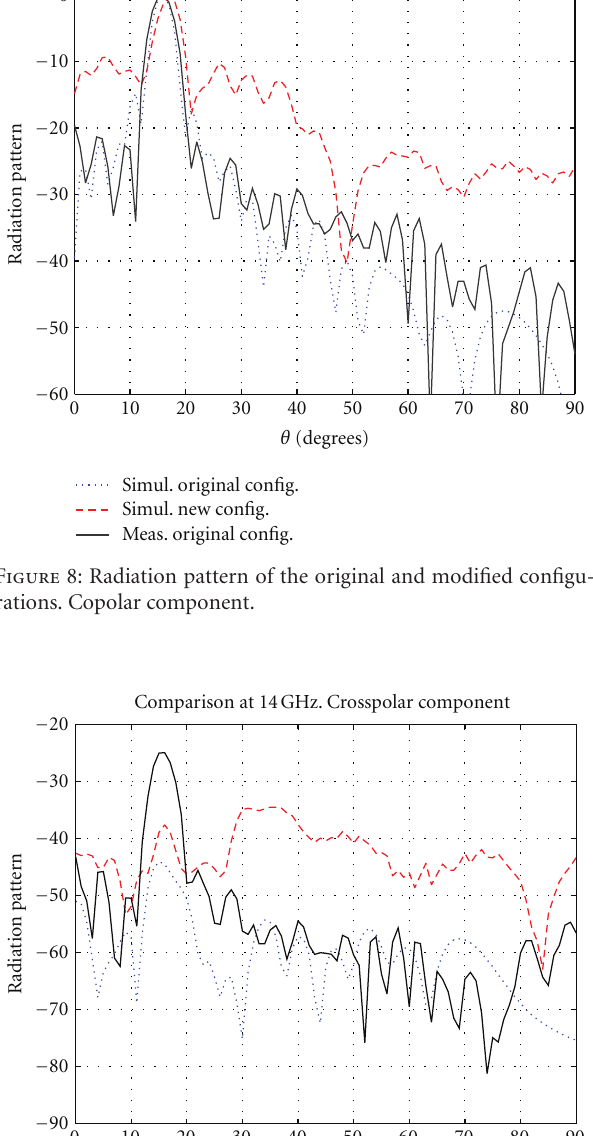
Simul. original config. Simul. new config. Meas. original config. Figure 9: Radiation pattern of the original and modified configu- rations. Crosspolar